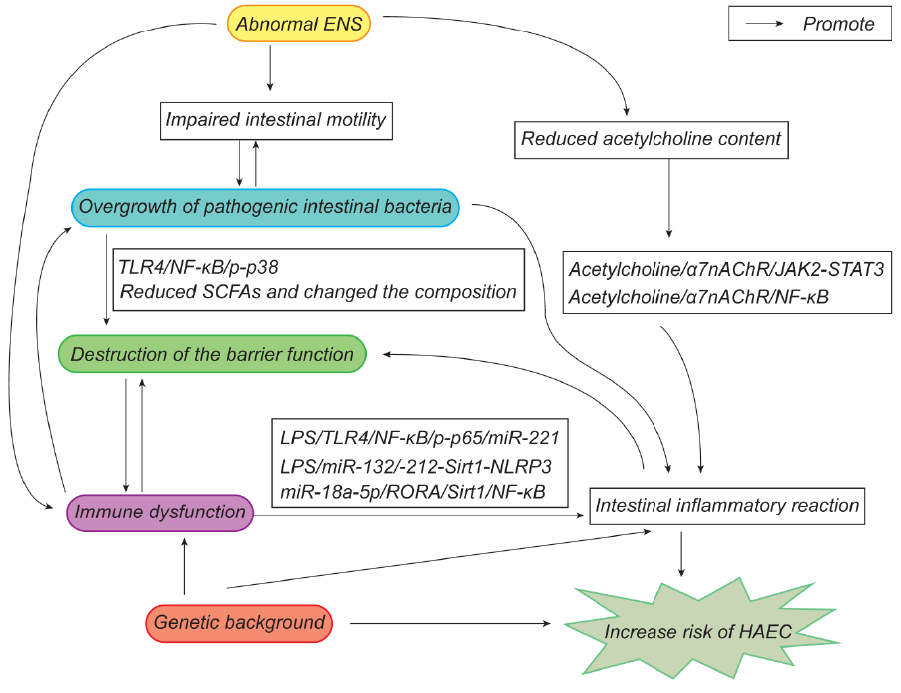
Figure 5. Updated pathogenesis of HAEC.